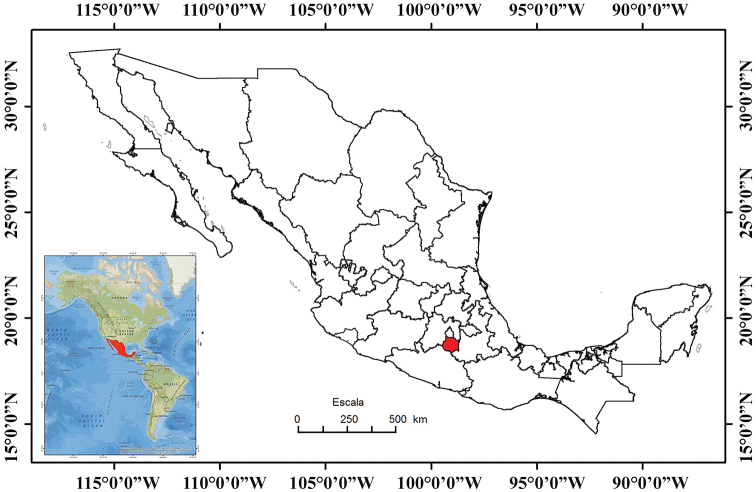
Map of Mexico with the state of Morelos shown in red (modified from INEGI 2018).